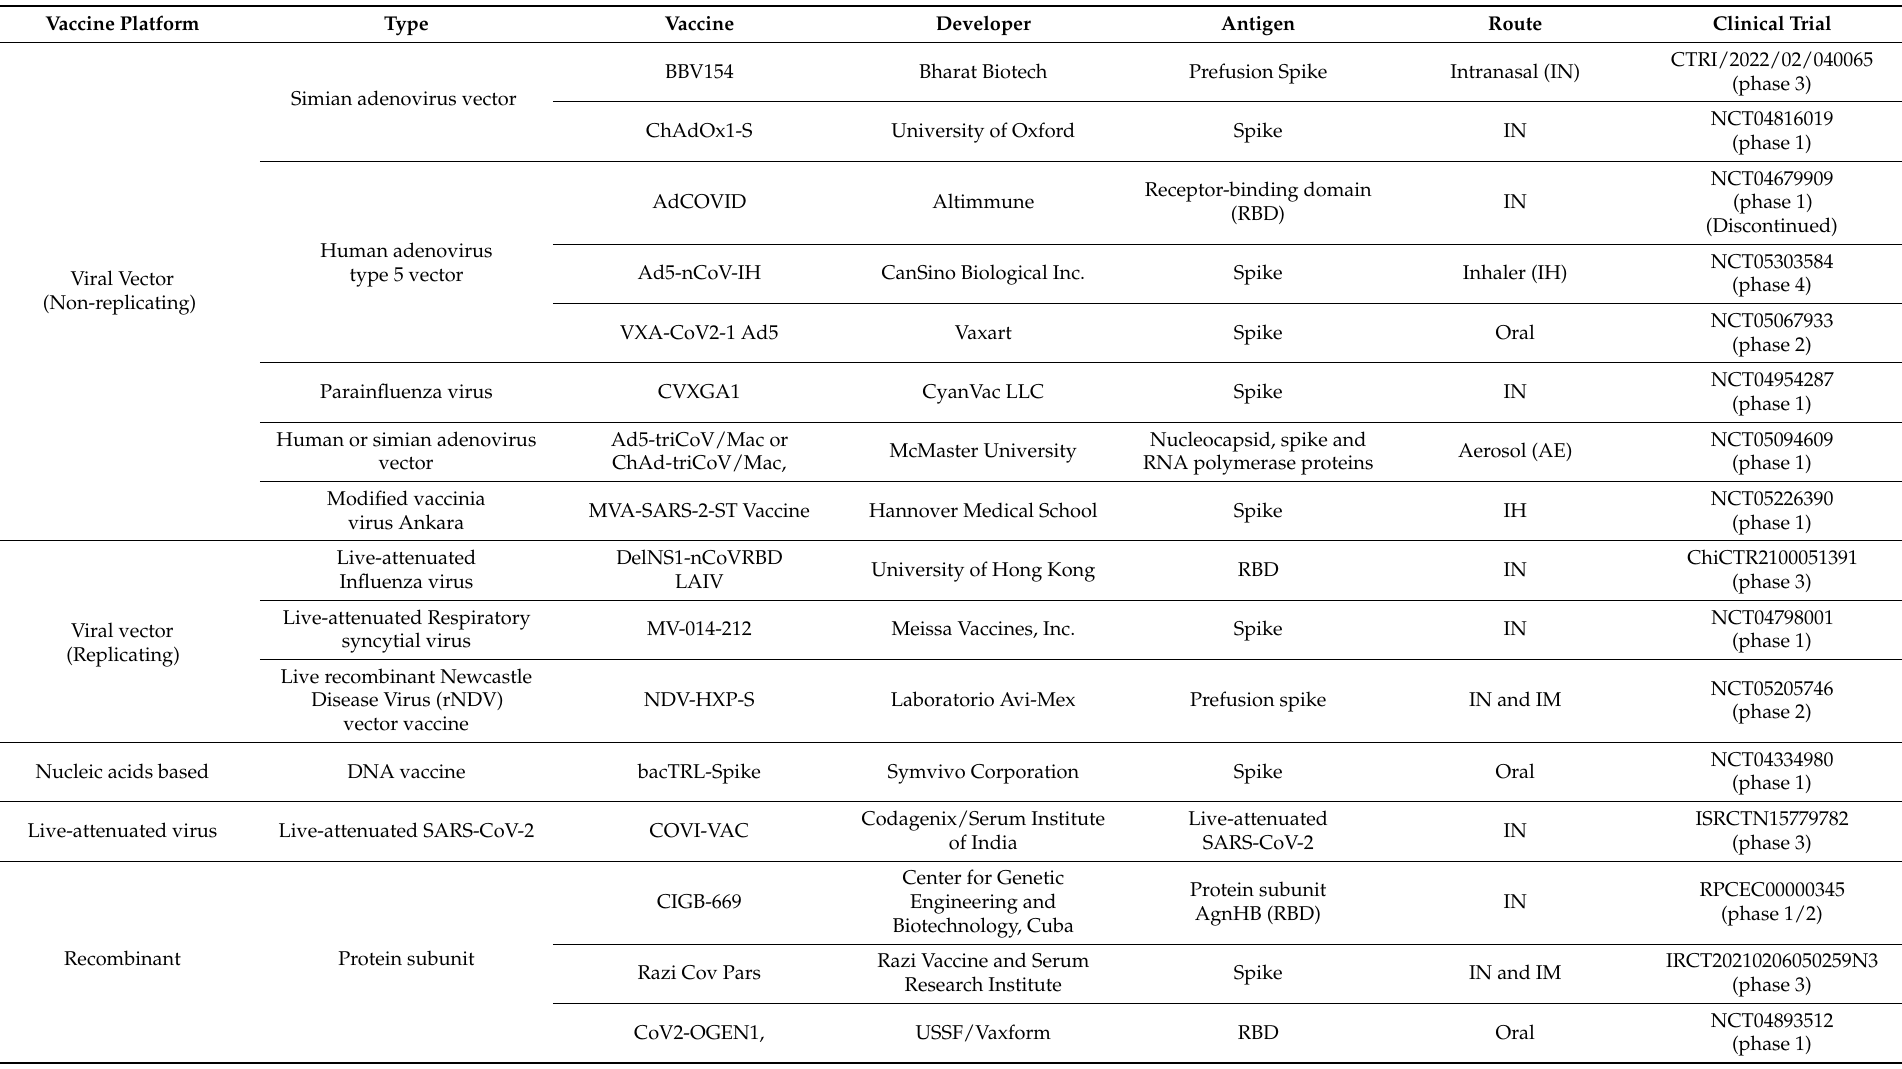
Table 2. Mucosal SARS-CoV-2 Vaccines in Clinical